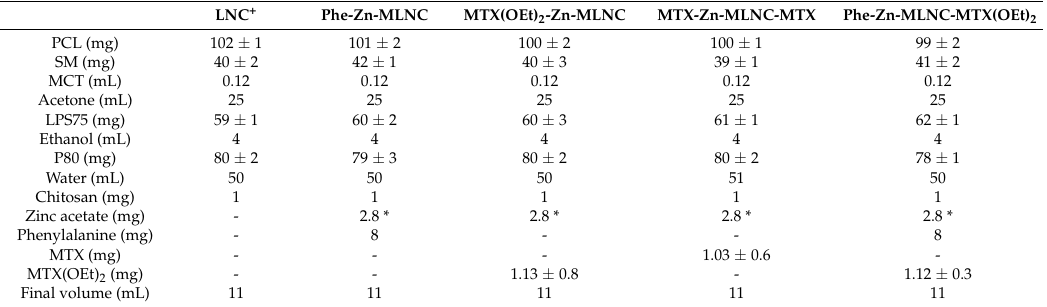
Table 3. Quali-quantitative composition of LNC + , Phe-Zn-MLNC, Phe-Zn-MLNC-MTX(OEt) 2